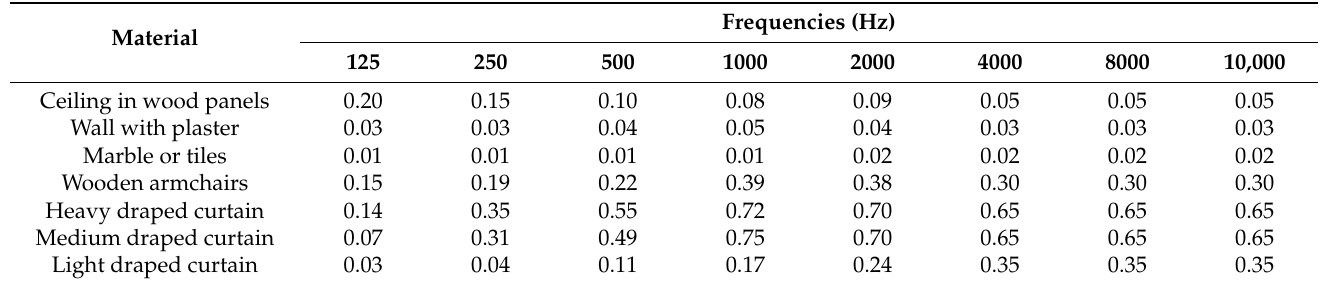
Table 8. Sound absorption factors of elements and construction materials used.